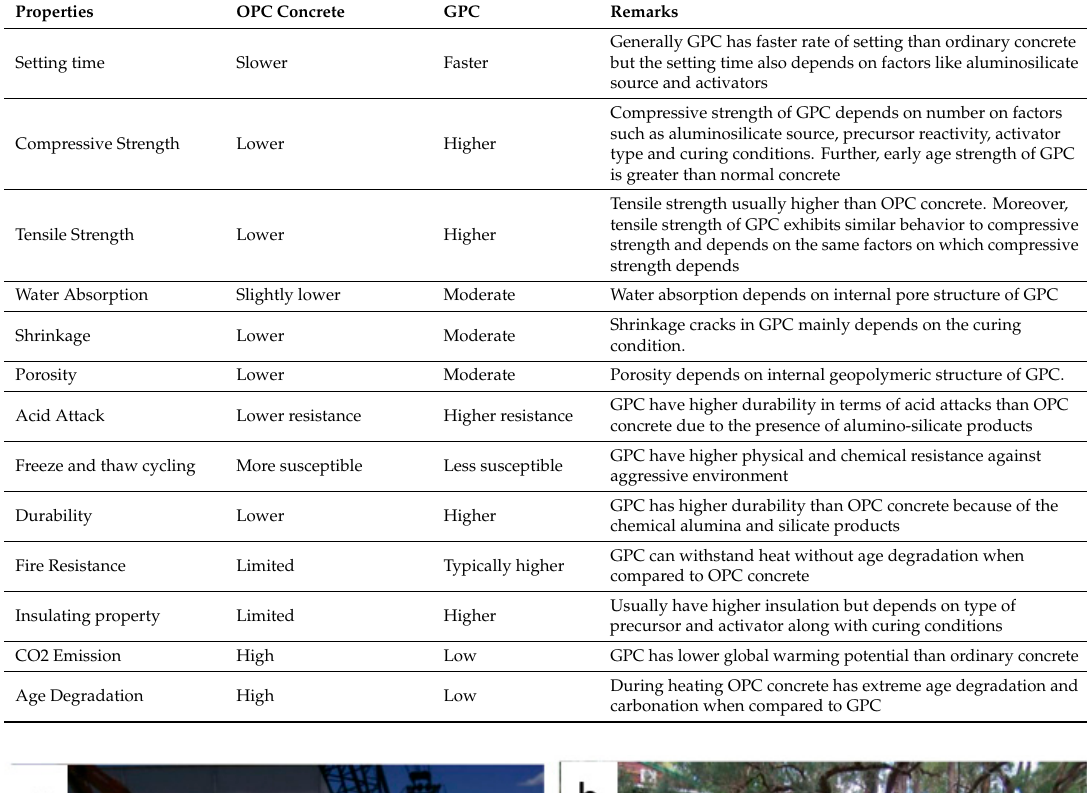
Table 10. Comparison between OPC concrete and GPC.